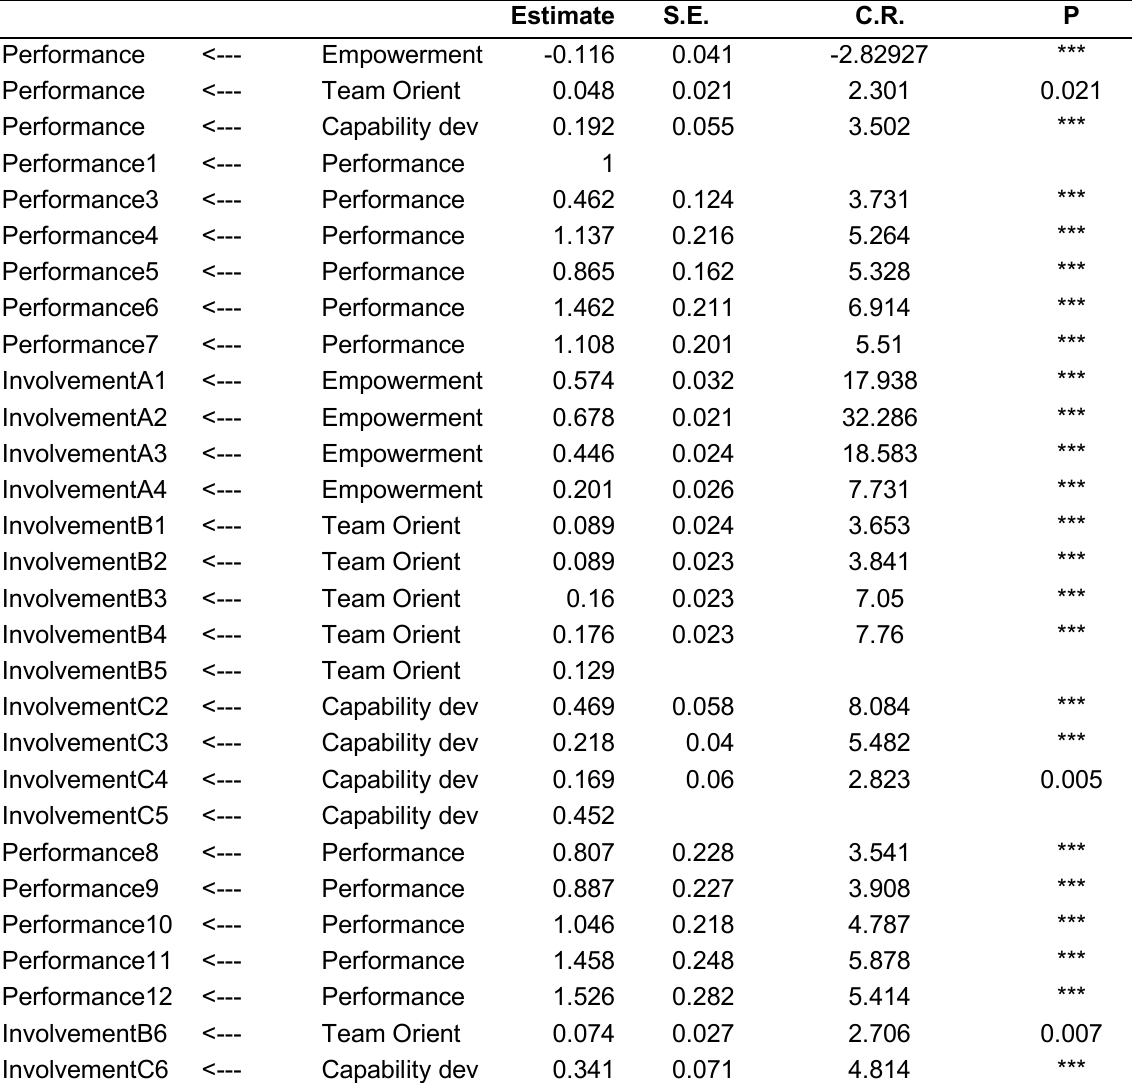
Table 4: Path Coefficients of the Structural Model on The Effect of Involvement on Performance Estimate S.E. C.R.